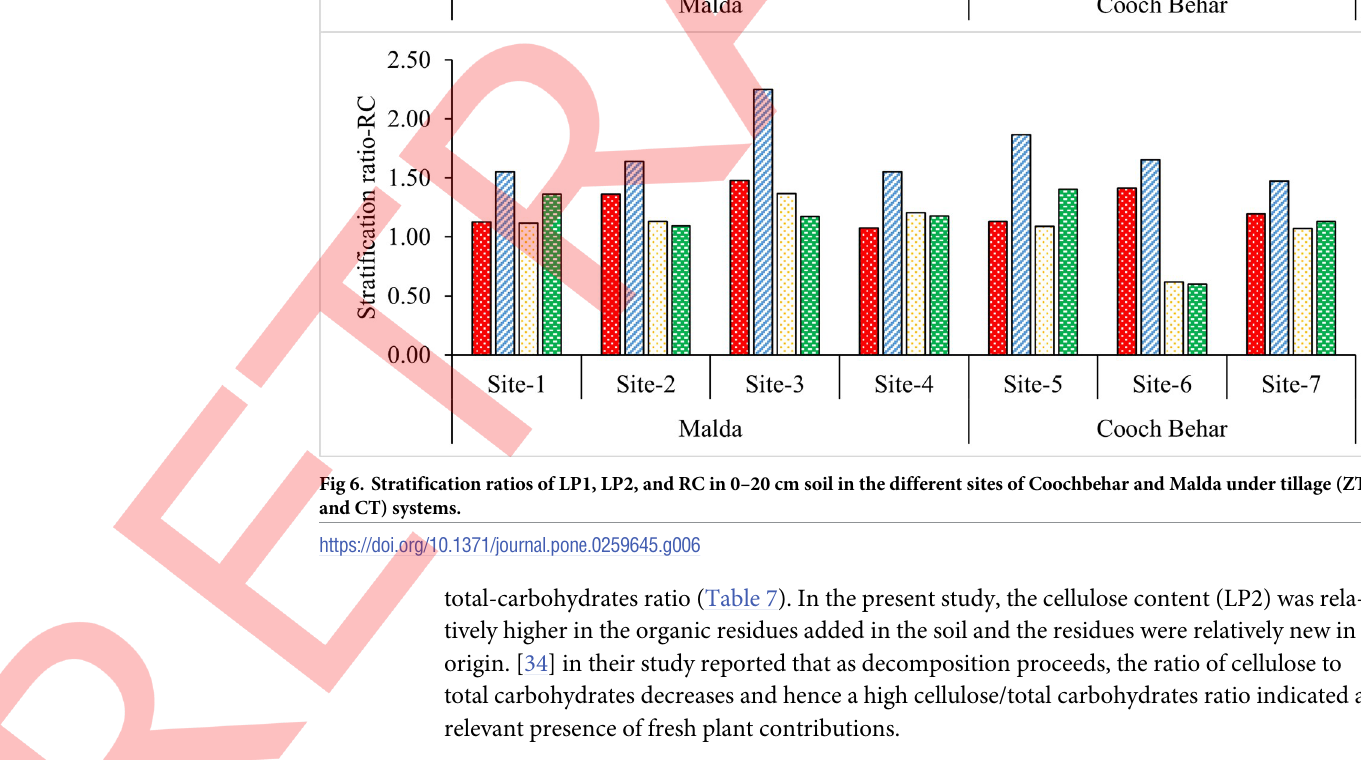
relevant presence of fresh plant contributions.